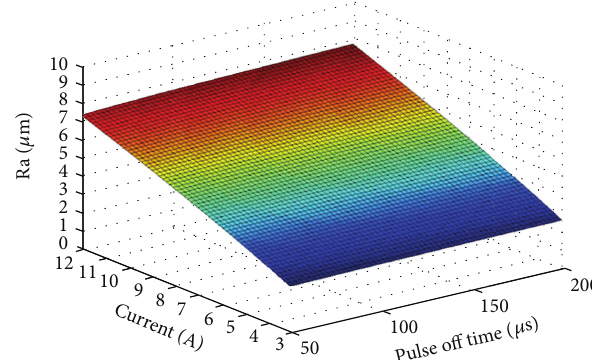
Figure 6: Effect of pulse off time and current on surface roughness (Ra) at pulse on time = 125 𝜇 s.